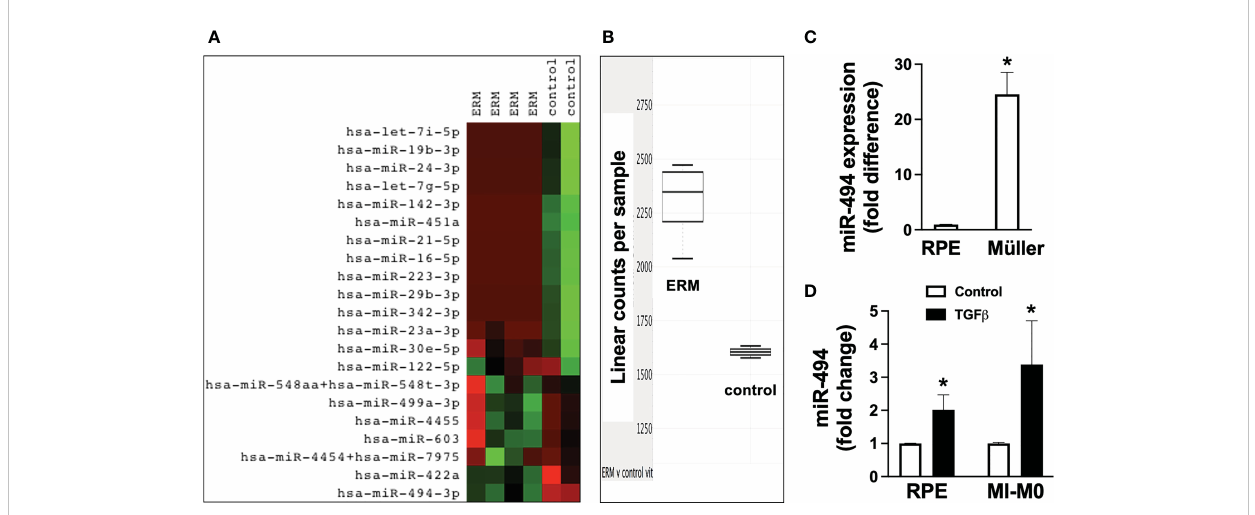
FIGURE 1 Expression of miR-494-3p in clinical epiretinal membrane (ERM) samples and in vitro after transforming growth factor beta (TGF b ) stimulation in human Müller cell line and human retinal pigment epithelial cell (RPE) cell lines. Heat map (A) of miR expression pro fi les and RT-qPCR quanti fi cation (B) of miR-494- 3p from 4 ERM samples were compared with pro fi les from 2 vitreous samples from eyes without ERMs. Expression of miR-494 in human Müller cell line and human RPE cell line at baseline (C) and 72h after incubation with TGF b (D) . Mean ± SEM, * p<0.05 versus RPE or TGF b versus control